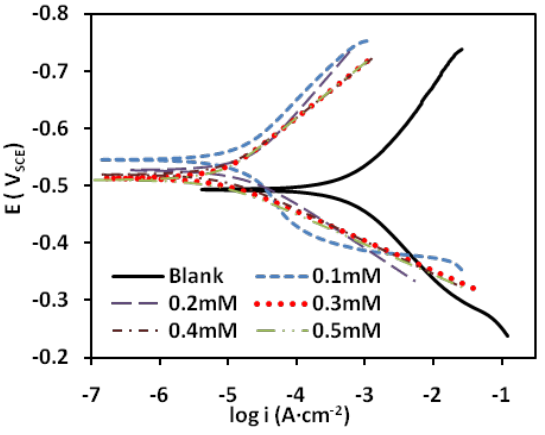
Figure 3. Potentiodynamic polarization curve for mild steel in 1.0 M HCl with various concentrations of the PMBH at 30 °C.